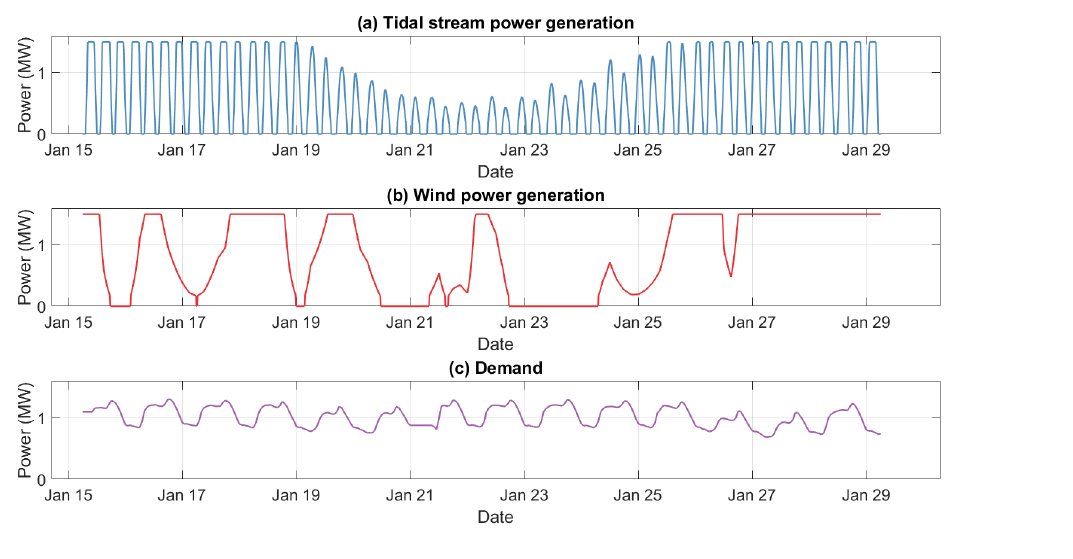
Figure 5. Two week power generation time-series from the ( a ) tidal stream turbine and ( b ) wind turbine, and ( c ) Alderney demand.